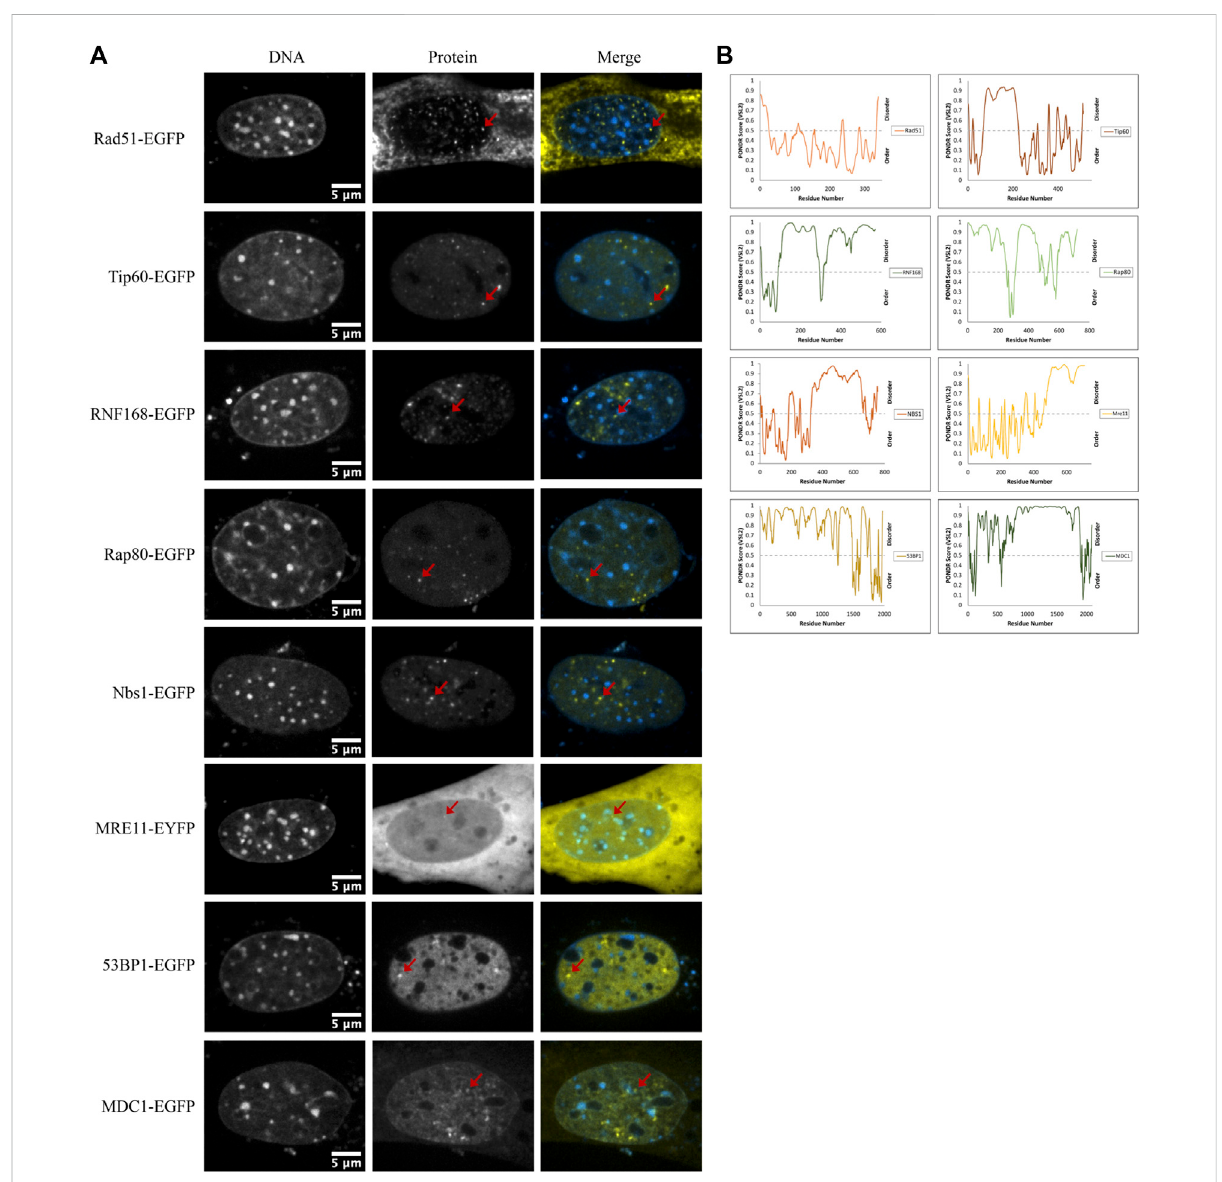
FIGURE 7 DNA damage sensors, mediators, and effectors form nuclear foci. (A) Example images of Rad51-EGFP, Tip60-EGFP, RNF168-EGFP, Rap80- EGFP, NBS1-EGFP,MRE11-YFP, 53BP1-EGFP, and MDC1-EGFP transfectedCH3/10T1/2 cells stained with Hoechst 33342displaying nuclear foci. (B) PONDR ® scores for each protein predicted by the VSL2 algorithm. A score greater than 0.5 predicts disorder for that region of the